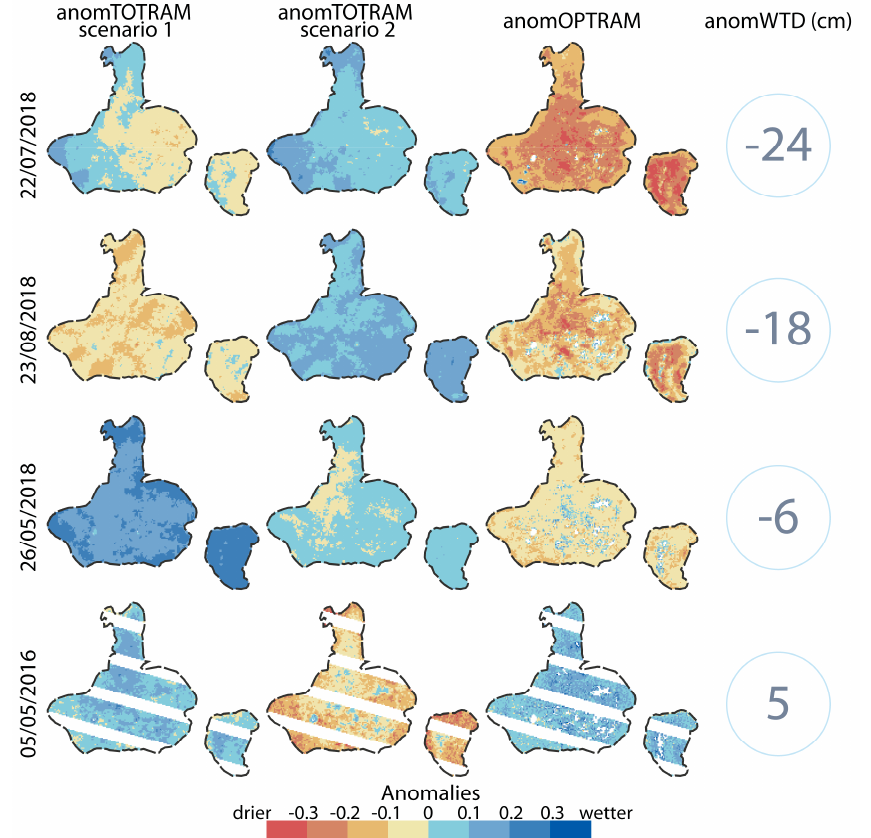
Figure 11. Maps of anomalies in soil moisture index derived from TOTRAM Scenario 1, TOTRAM Scenario 2, and OPTRAM for four exemplary dates and corresponding anomalies in water table depth (anomWTD) averaged over all the monitoring wells. The white areas within the bogs represent missing data resulting from Landsat 7 Scan Line Corrector failure (striped pattern on 05/05/2016) or methodological constraints (filtering of oversaturated pixels in OPTRAM).